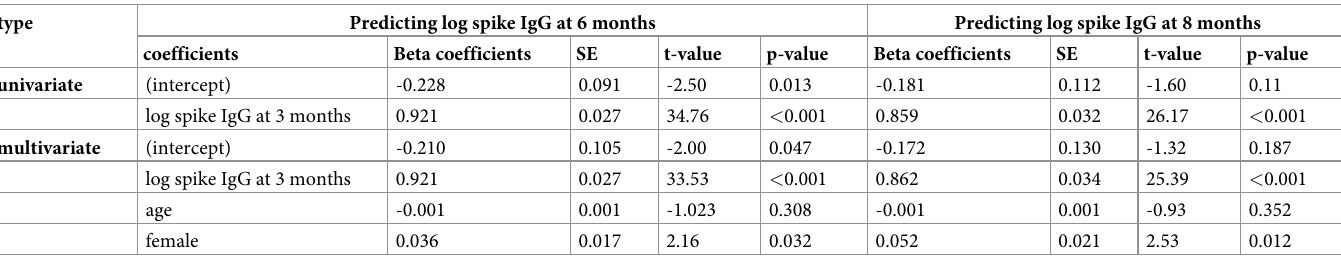
Table 2. Univariate and multivariate linear regression analysis for the association of log-transformed spike IgG titers at 6 months and that at 8 months.